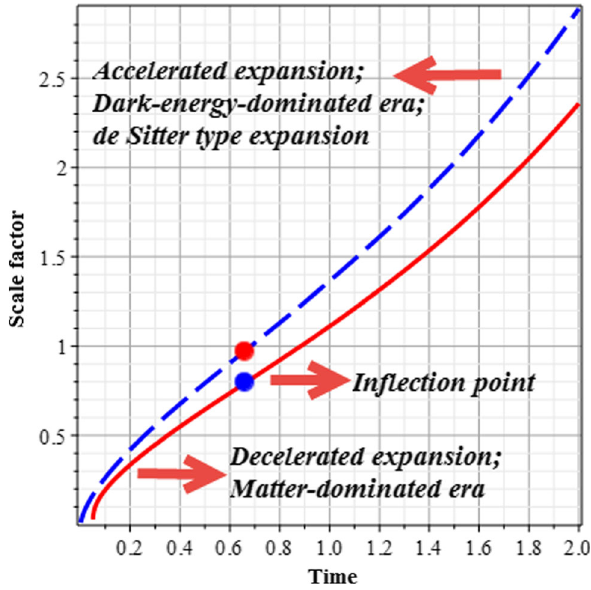
Fig. 3 The solid curve indicates the behavior of scale factor (34) for √ the values c 5 c 7 = − 1 / 6, w 4 = 1, and θ = 0 . 1 while the dashed curve demonstrates the plot of (40) for the values w 1 = 0 . 01 and w 4 =